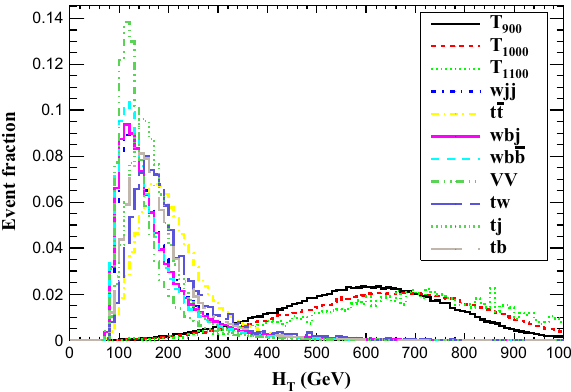
Fig. 3 Normalized scalar sum of the transverse momenta H T for the signals and backgrounds